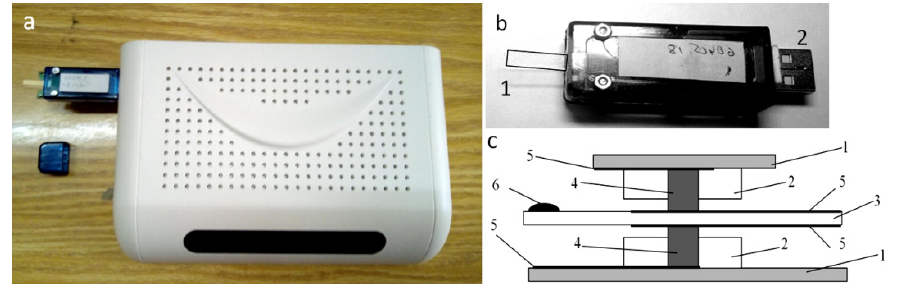
Figure 3. ( a ) Photo of a modified version of the device, overall dimensions: 200 × 140 × 50 mm, weight 200 g. ( b ) Sensor module detached from the device body: 1—quartz resonator and 2—USB-connector.